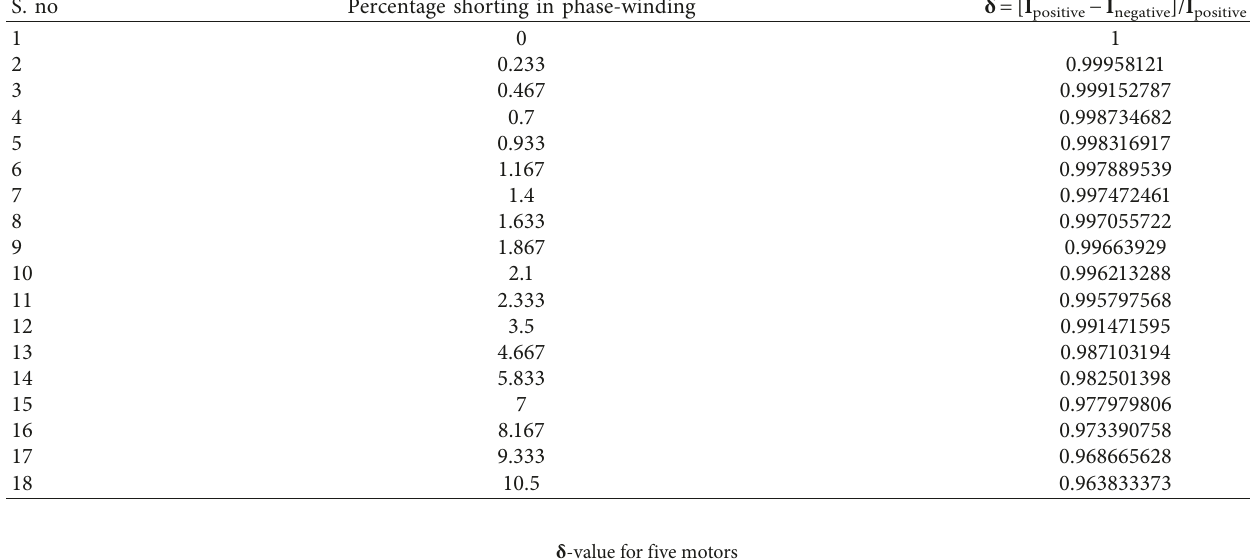
Table 4: Calculated parameter values.